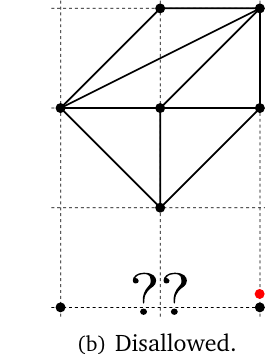
Figure 4: Left: An example of an allowed vertical reduction of a toric diagram Γ , leading to a resolved A singularity (cid:98) Y , pictured by the 1d toric diagram at the bot- 1 tom. The vertical lines in the middle of Γ are mapped to a single exceptional curve ∼ = (cid:80) 1 ⊂ Γ is mapped D (cid:98) Y (cid:98) Y wrapped by two D6-branes. The vertical line on the right of 1 ∼ = (cid:67) ⊂ to a single D6-brane along the non-compact divisor D (cid:98) Y (cid:98) Y . Right: An example 2 of a triangulation without an allowed vertical reduction, because there is an edge with ∆ v = ( 2,1,0 )